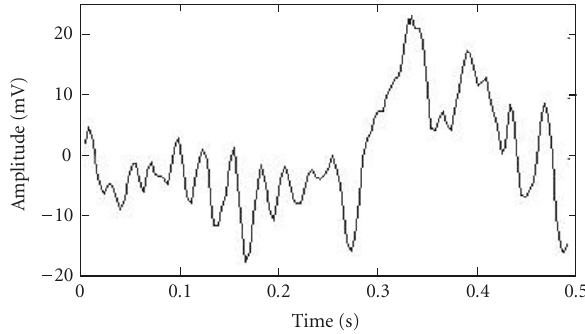
Figure 15: Visual P300 obtained using